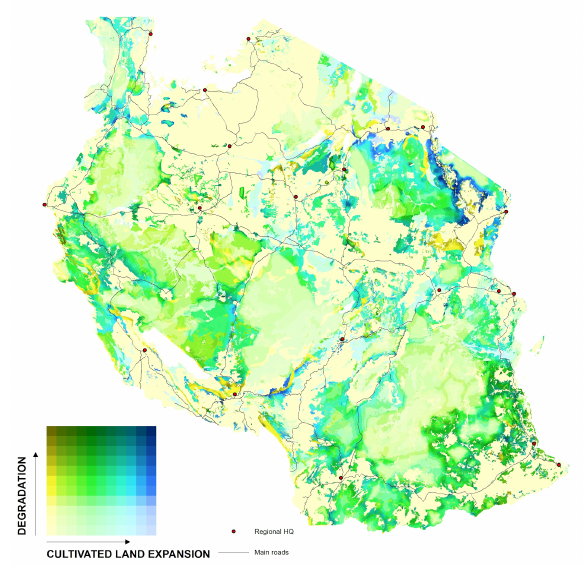
Fig. 3 . Bivariate representation of land use and land cover changes (LULCC) likelihood composite indicators for cultivated land expansion (light yellow-light blue) and degradation (light yellow-green) for all land cover classes, under business as usual (BAU) scenario. Areas where such LULCC were not expected are shown in light yellow, e.g., existing cultivated